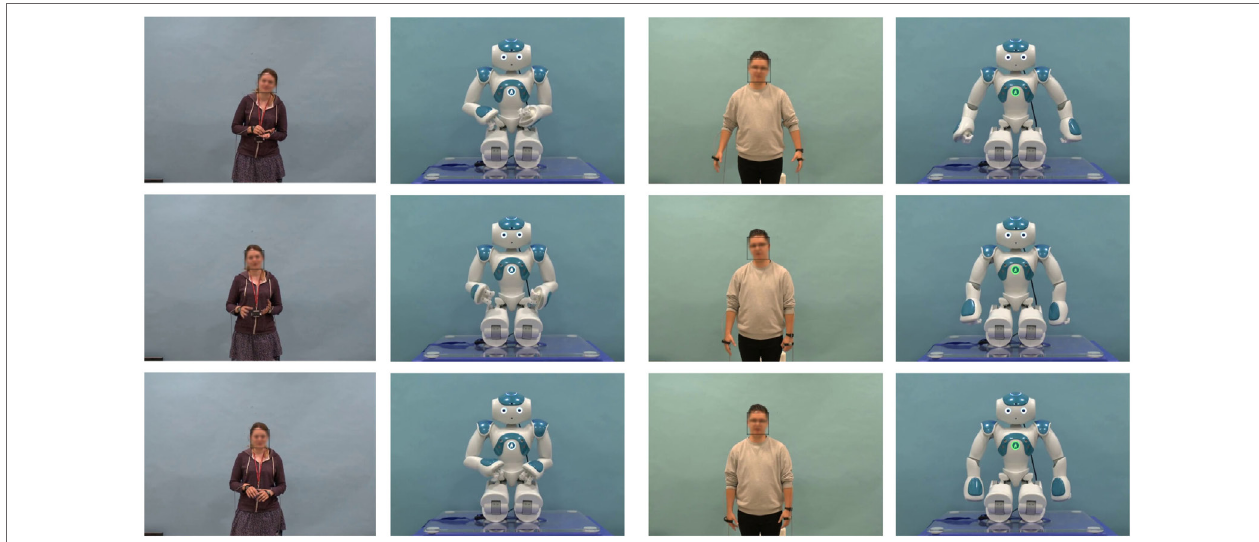
FigUre 1 | snapshots from the solo Tasks study . Left hand side: a target perceived to be extroverted by judges. Right hand side: a target perceived to be introverted by